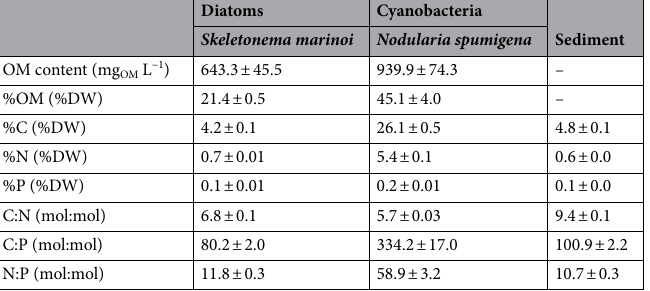
Table 2. Organic matter (OM) content and elemental composition of the two plankton slurries and initial sediment (mean ± SE, n = 5). OM content was estimated from loss-on-ignition. C, N and P content are expressed as % dry weight (DW), ratios are in